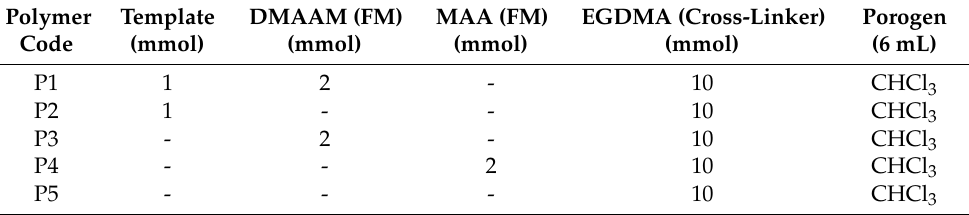
Table 1. Summary of the molecularly imprinted polymer (MIP), P1 and P2, and non-imprinted polymer (NIP), P3–P5, synthetic preparations used in this investigation 1